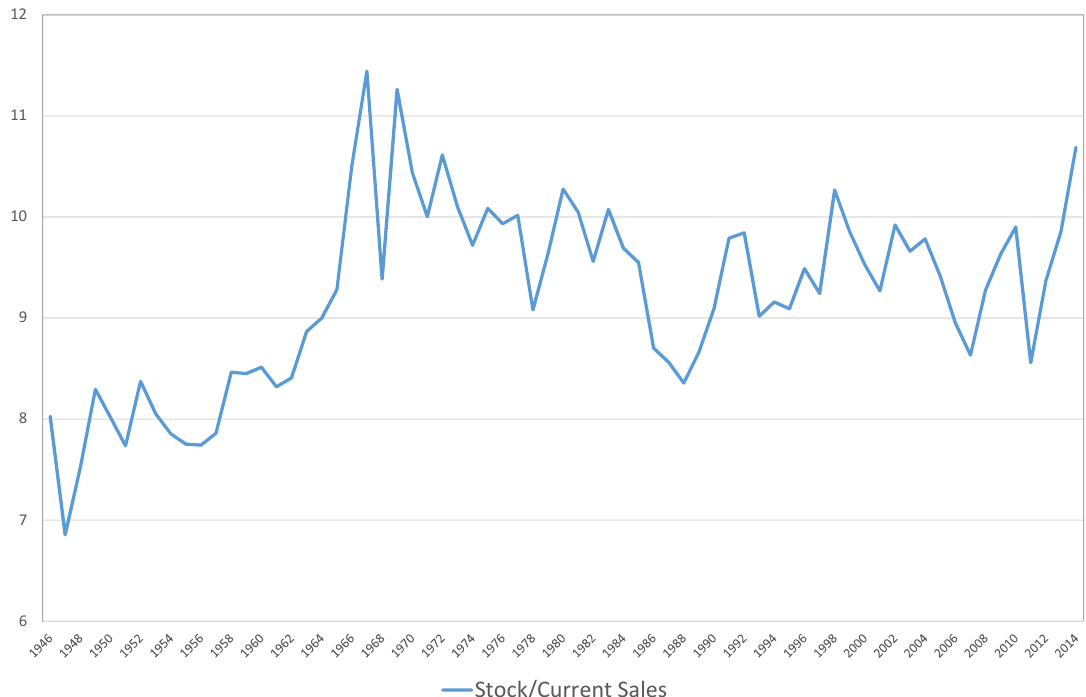
Figure 5. Stocks to sales ratio. Constructed from SWA statistics and The making of Scotch whisky as outlined above.